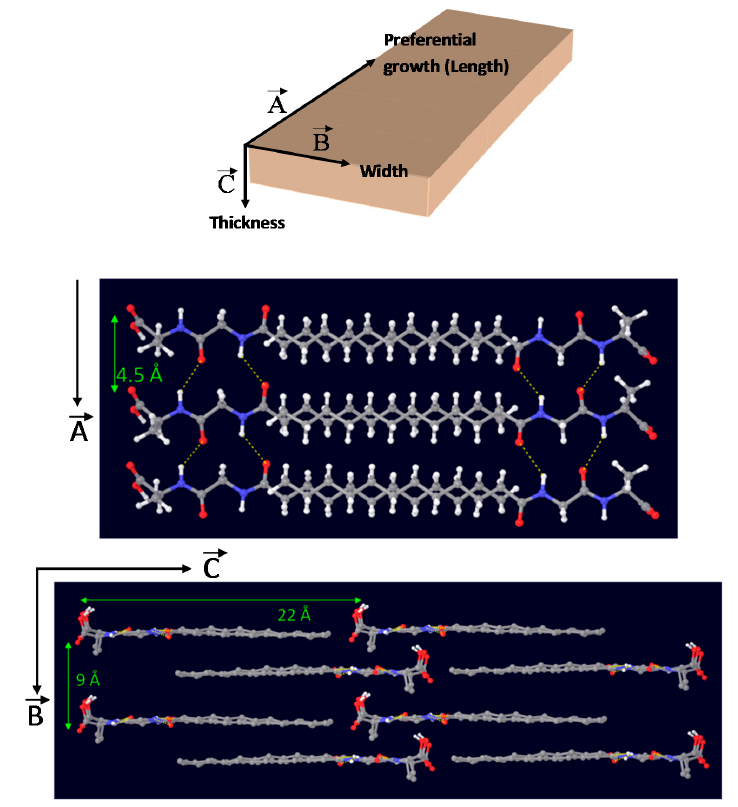
Figure 4. Energy-minimized structure models (MACROMODEL 7.0, AMBER* [98]) for the packing of compound C12GA in phosphorylated xerogel (non-polar hydrogens are omitted for clarity in the bottom image).